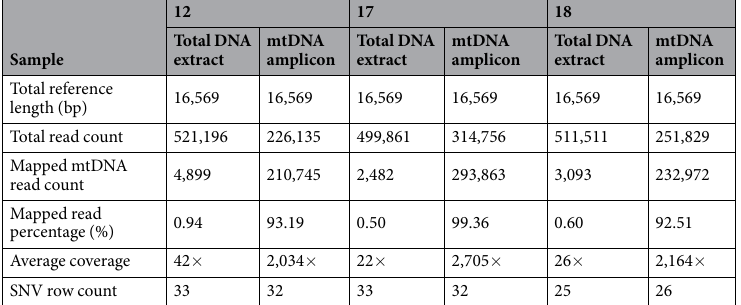
Table 3. Sequencing metrics of total DNA extract and mtDNA amplicon. Runs of all three patients’ samples were performed independently in triplicates. mtDNA = mitochondrial DNA; SNV = single nucleotide